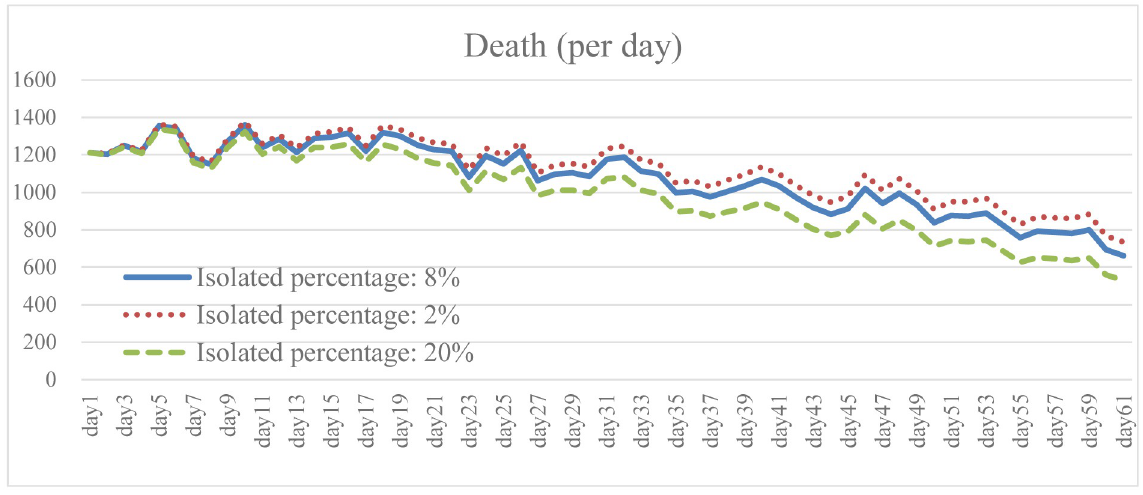
Fig 6. Daily death under different isolation percentage.